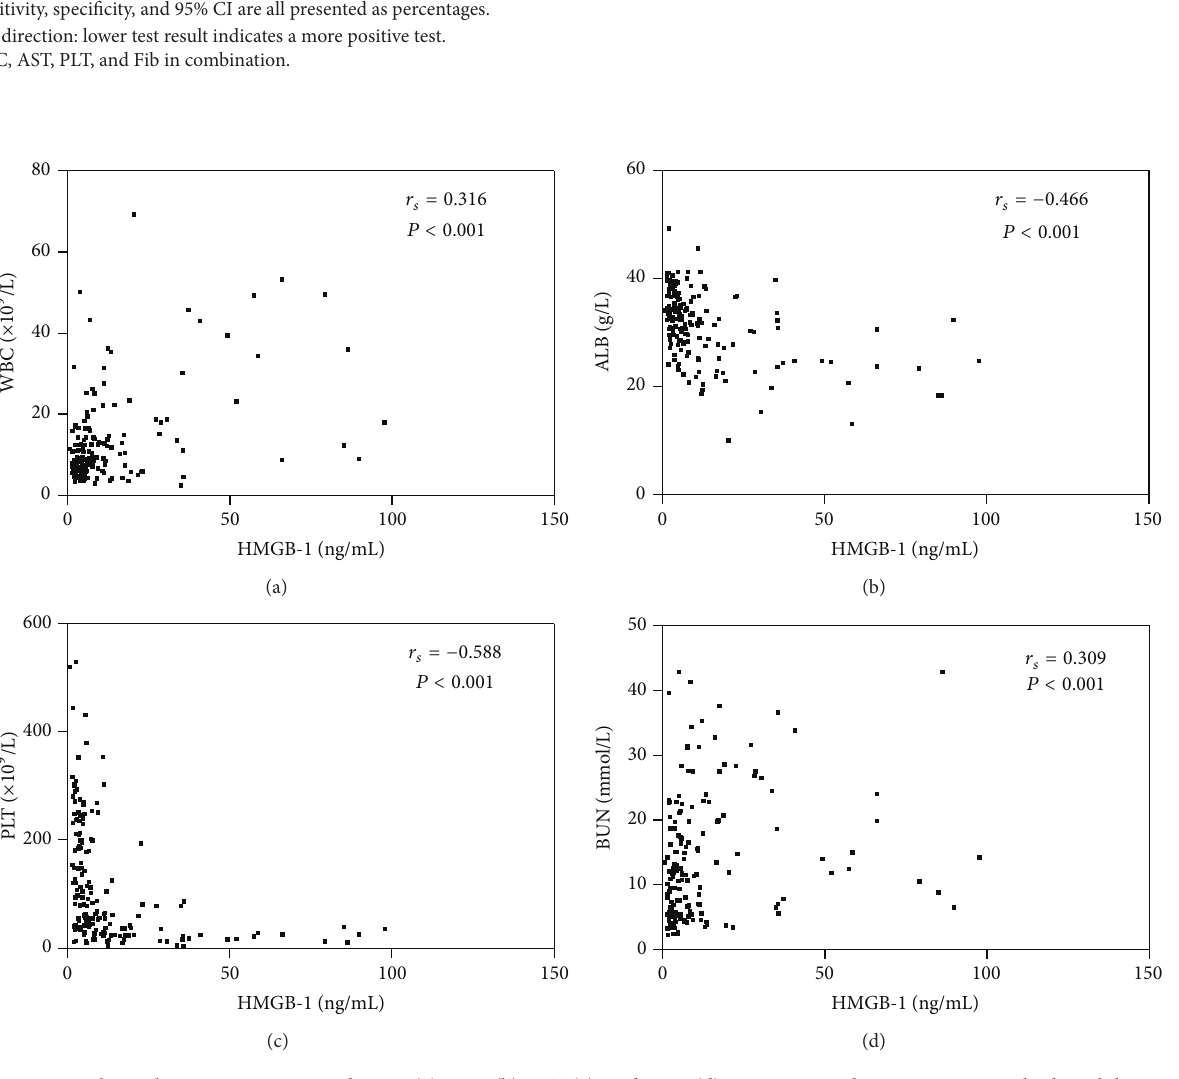
AUC: area under the curve; CI: confidence interval; HMGB-1: high mobility group box protein-1; WBC: white blood cells; PLT: platelets; HCT: hematocrit; ALB: albumin; BUN: blood urea nitrogen; Scr: serum creatinine; UA: uric acid. a 𝑃 value for calculated AUC in predicting death. b